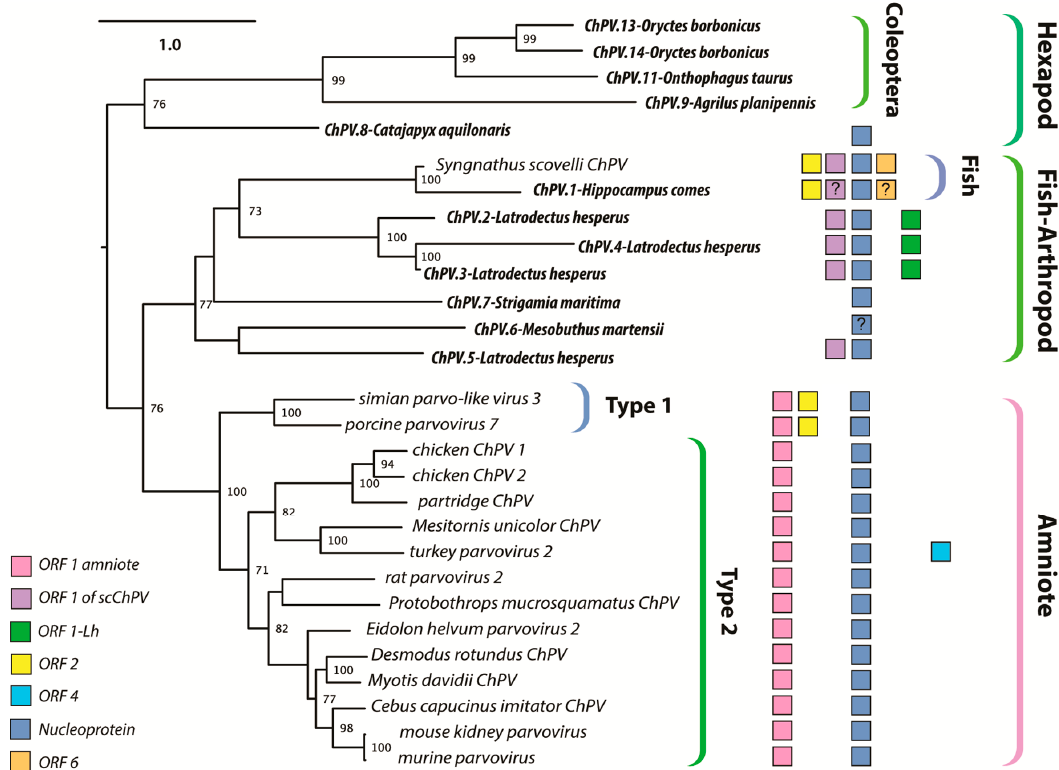
Figure 4. Maximum likelihood phylogenetic reconstructions of the ChPV clade based on the complete aligned amino acid sequences of the NS1. Colored boxes indicate the presence of auxiliary open reading frames (ORFs), as shown in the inset key. The “?” character indicates that the presence of an ORF is suspected but not confirmed. Taxa labels in bold italics indicate endogenous sequences, whereas italics indicate sequences known or believed to derive from viruses. Brackets to the right indicate taxonomic groups. The scale bar (top right) shows evolutionary distance in substitutions per site. Numbers adjacent to tree nodes show bootstrap support (based on 100 bootstrap replicates) where >